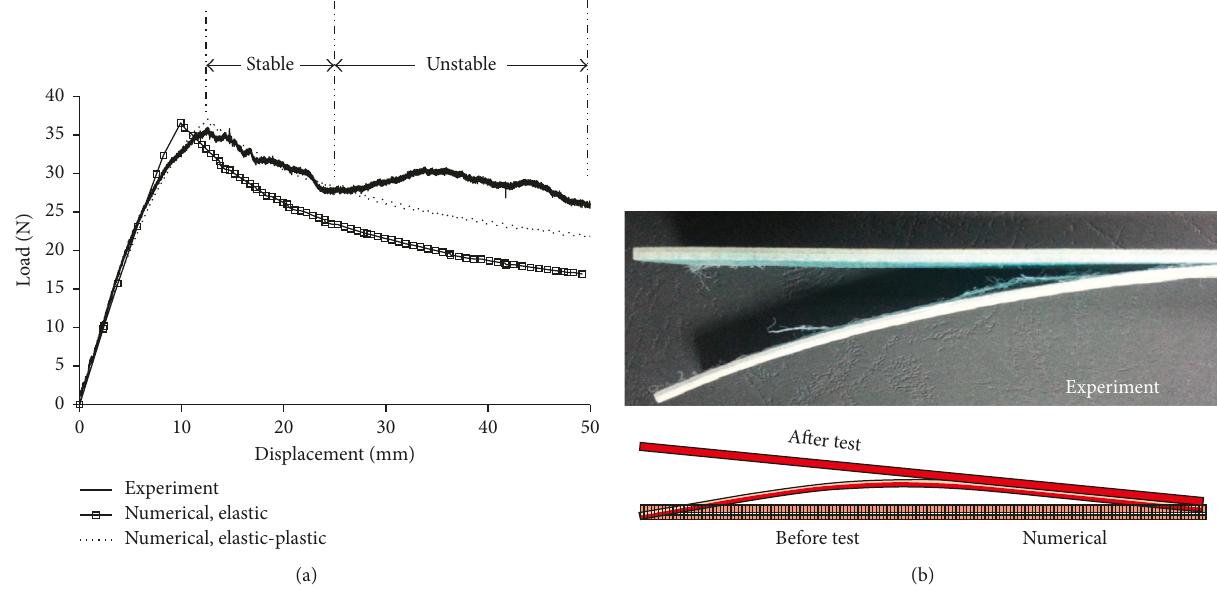
Figure 8: Mode-I fracture of the C-M-C configuration: (a) load-displacement curve and (b) permanent plastic deformation.